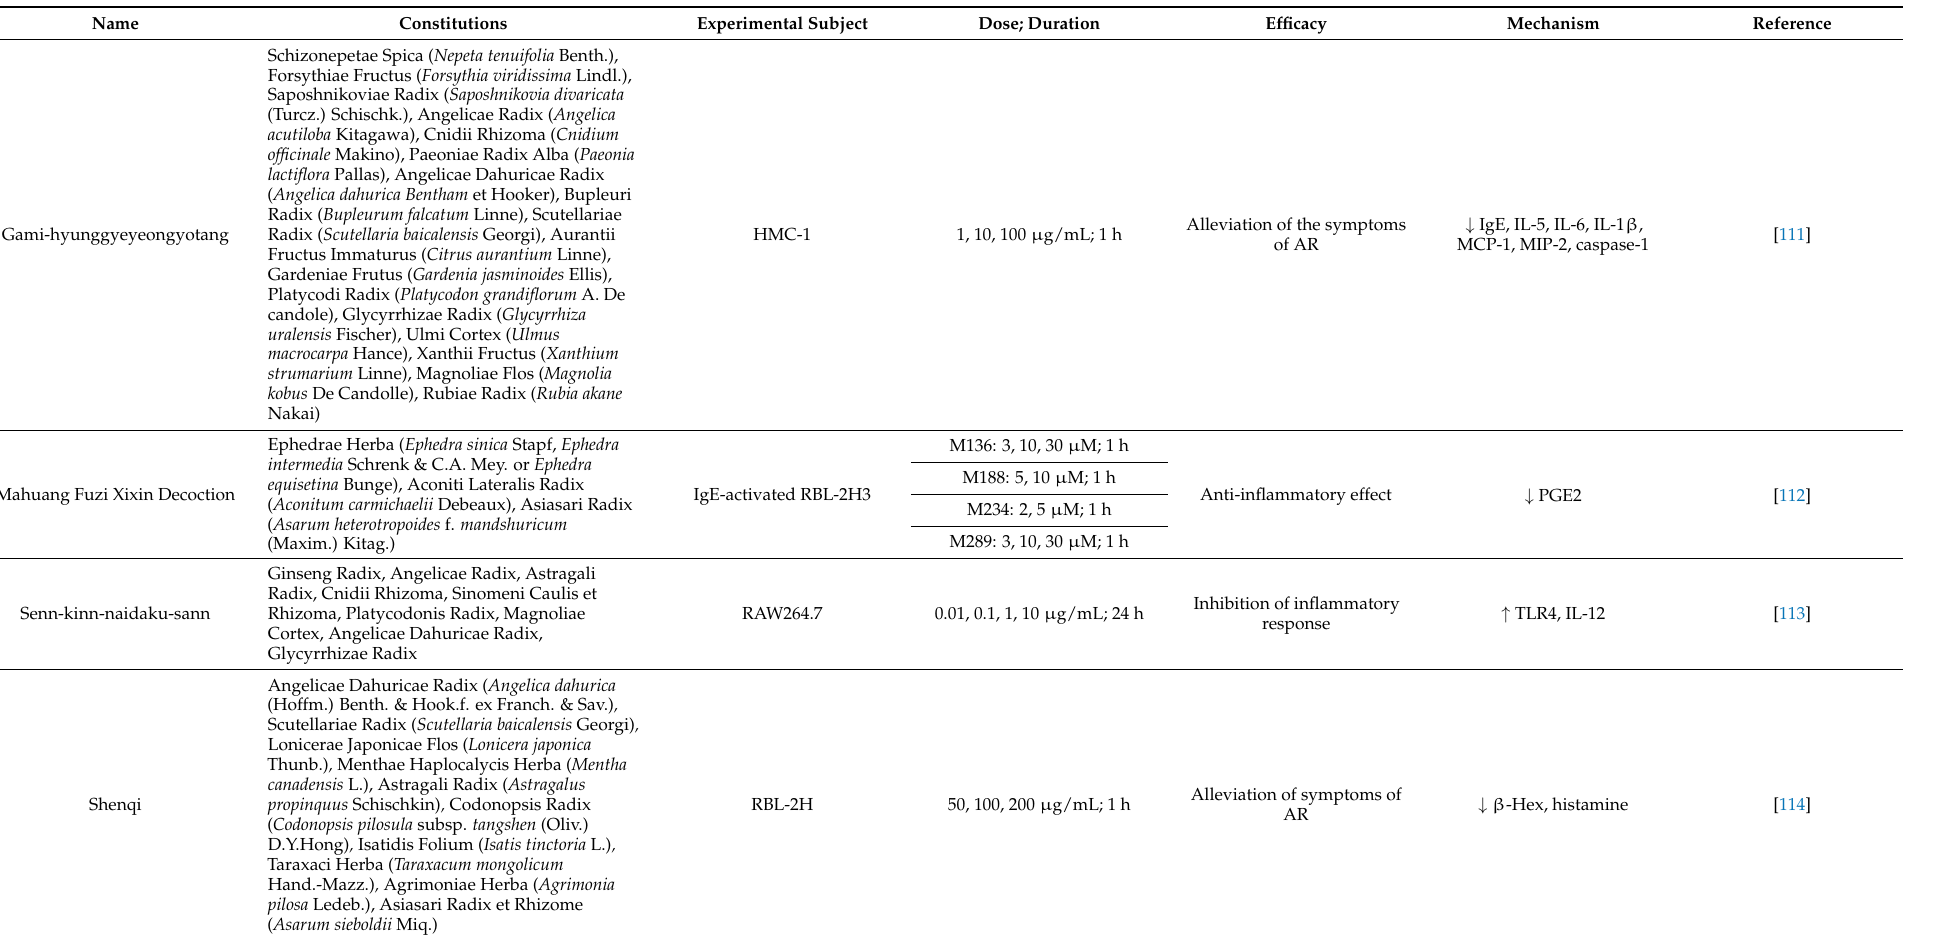
Table 5. In vitro studies—decoctions of natural